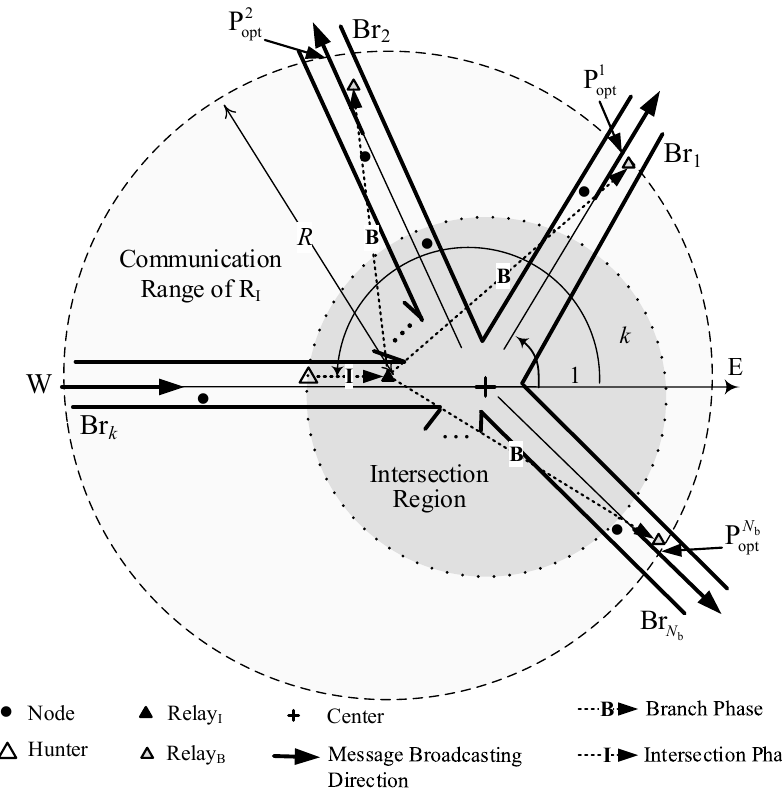
Figure 2. General relay-node selection on